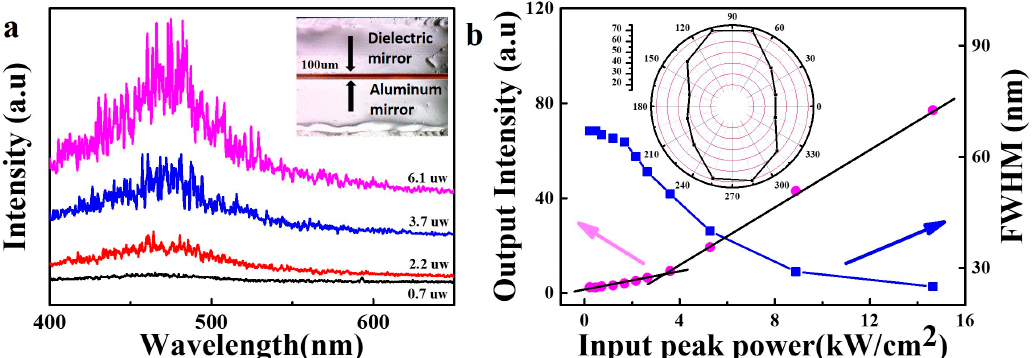
Figure 4. ( a ) Emission spectra versus different excitation power. The inset is the photograph of the designed microcavity ( b ) The output intensity and full width at half-maximum (FWHM) of the emission spectra versus input peak power. The inset polar patterns plot the lasing intensity at each given polarization state.